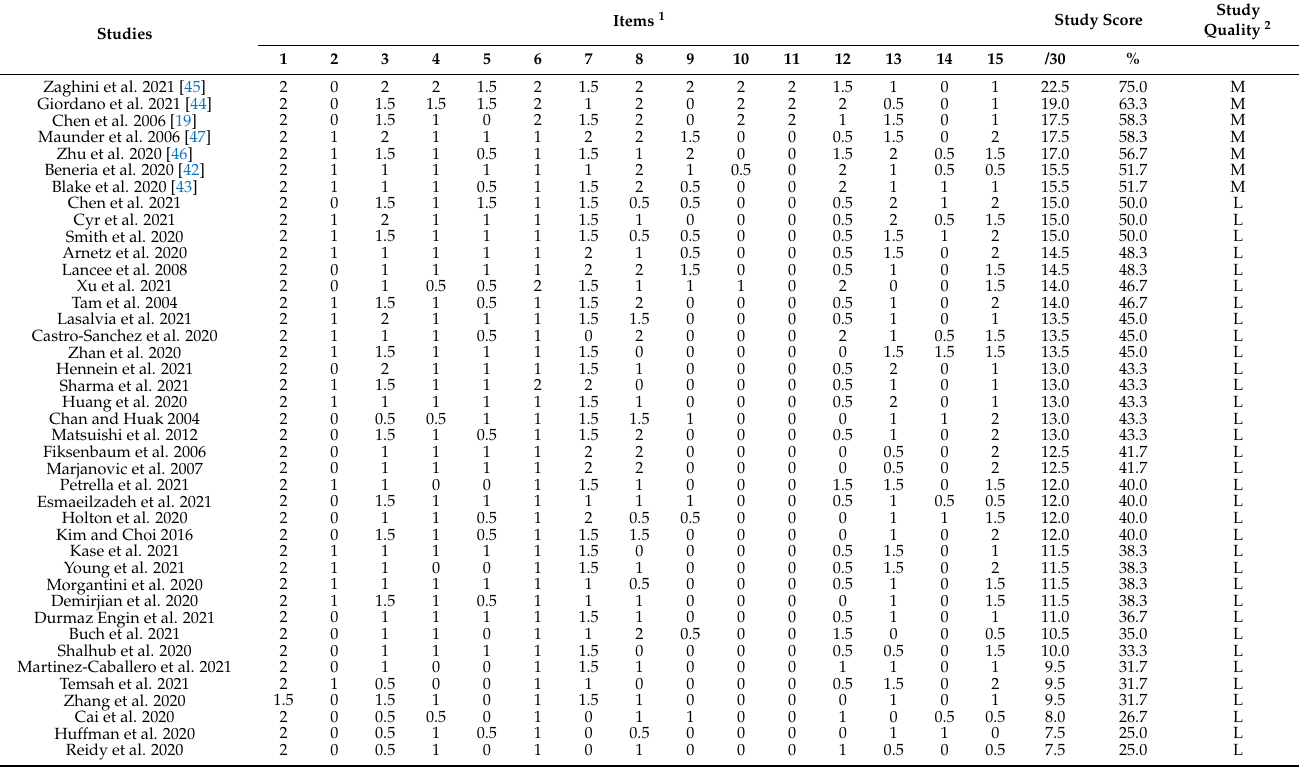
Table 1. Methodologic quality of individual